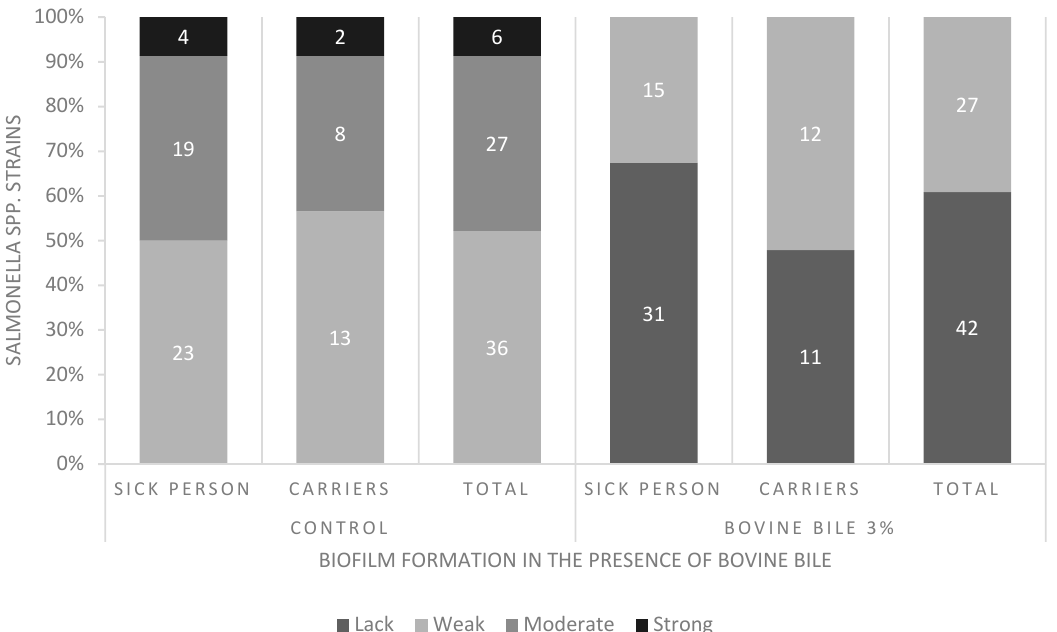
Figure 2. Biofilm of S. enterica strains ( n = 69) in TSB (control) and TSB medium with 3.0% bovine bile.